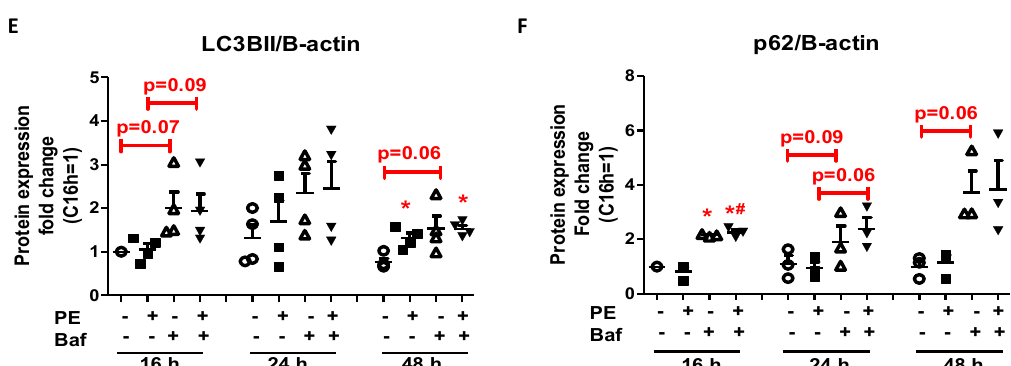
Figure 1. Time-dependent effects of phenylephrine on hypertrophic gene expression, protein synthesis, and autophagy. ( A , B ) mRNA expression levels of hypertrophic markers brain natriuretic peptide (BNP) and atrial natriuretic factor (ANF) after 16 h, 24 h, and 48 h treatment with phenylephrine (50 µ M), expressed in fold increase relative to control ( n = 5). ( C ) Protein synthesis after 16 h, 24 h, and 48 h stimulation with phenylephrine (50 µ M), using [14C] phenylalanine incorporation expressed in pCi/mg wet weight/hour. Data are presented as means ± standard deviation (STDEV) ( n = 5). ( D ) Representative Western blots of the autophagy-related proteins, LC3B and p62, after 16 h, 24 h, and 48 h phenylephrine (PE) stimulation compared to control. Co-treatment with bafilomycin was added to inhibit autophagic flux, and β -actin was used as the loading control. ( E , F ) Quantification of LC3BII and p62 protein levels normalized to β -actin. Values are expressed as fold increase ± STDEV relative to 16 h control incubation ( n = 3/ n = 4). * p < 0.05 compared to control, # p < 0.05 compared to PE were considered significantly different at the same incubation time.